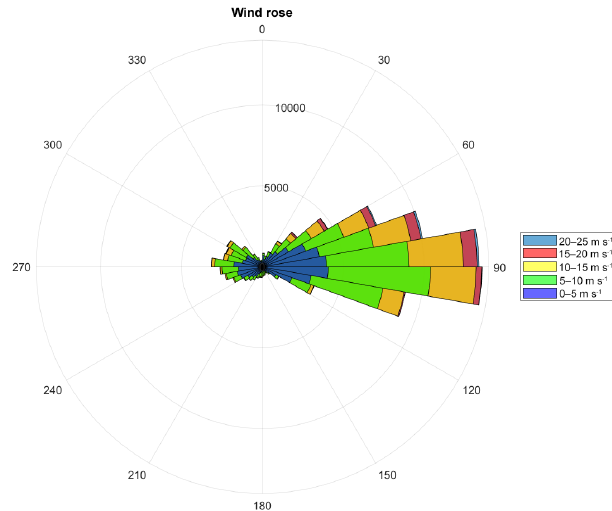
Figure 6. The wind rose for the Hornsund station for the period